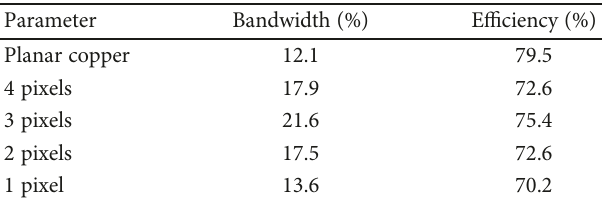
Table 2: Baseline planar copper dipole versus pixelated dipole. Parameter Bandwidth (%) E ffi ciency (%)